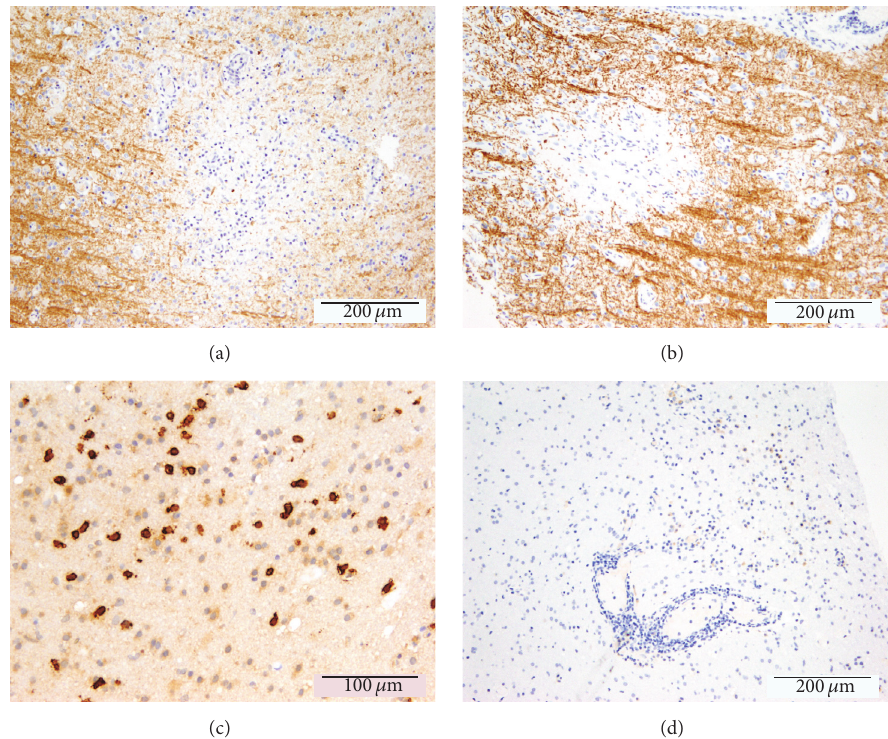
Figure 6: Neuropathological findings. Histology revealed areas of focal demyelination as indicated by a loss of myelin basic protein (a) and proteolipid protein (b). Despite the presence of prominent CD8 dominated inflammatory infiltrates (c), SV40-positive cells (JCV-infected cells, (d)) could not be